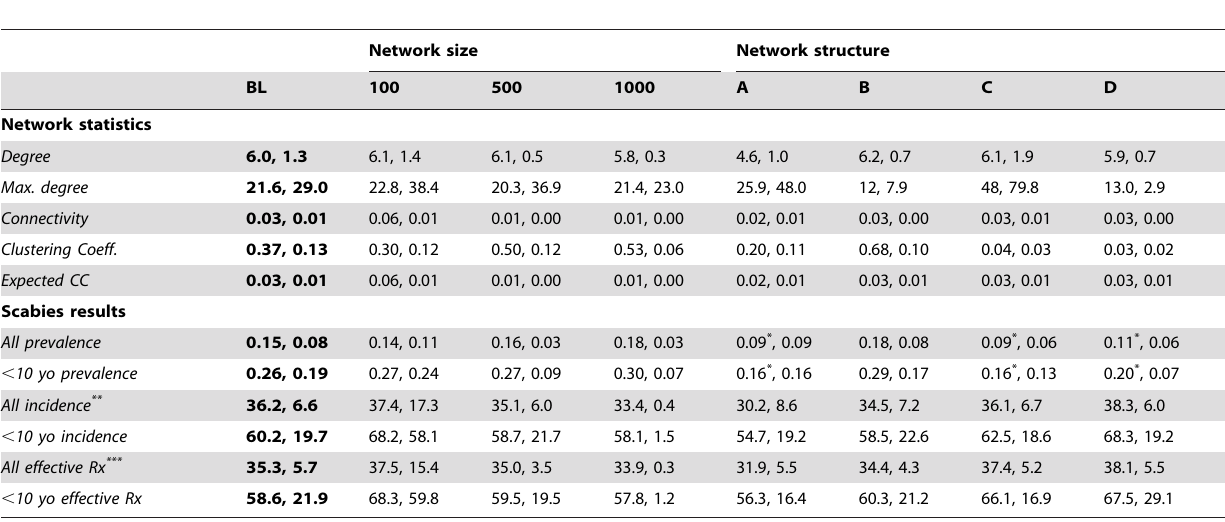
Table 1. Scenario 1 – treatment regime based on treating one index case and all first degree contacts every seven days ( Q =10 2 1.5